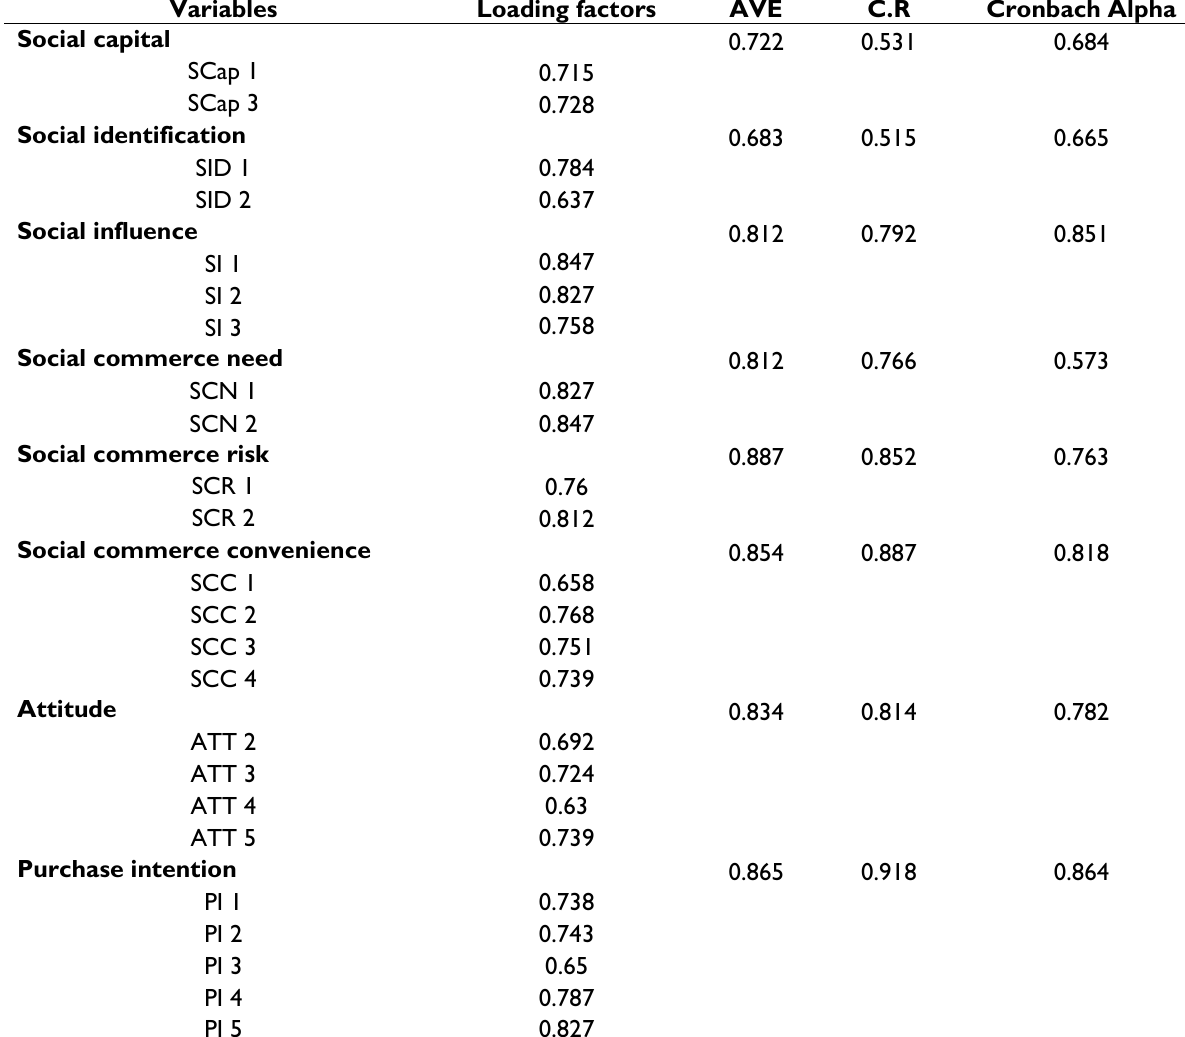
Table 2. CFA Results (Test of validity and